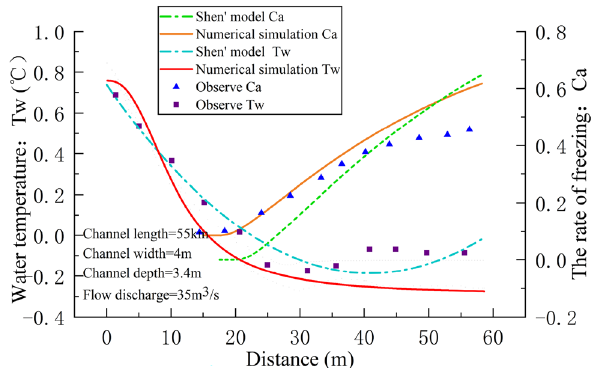
Figure 5. Water temperature and the rate of freezing at January 8(th), 3:00, 2012.